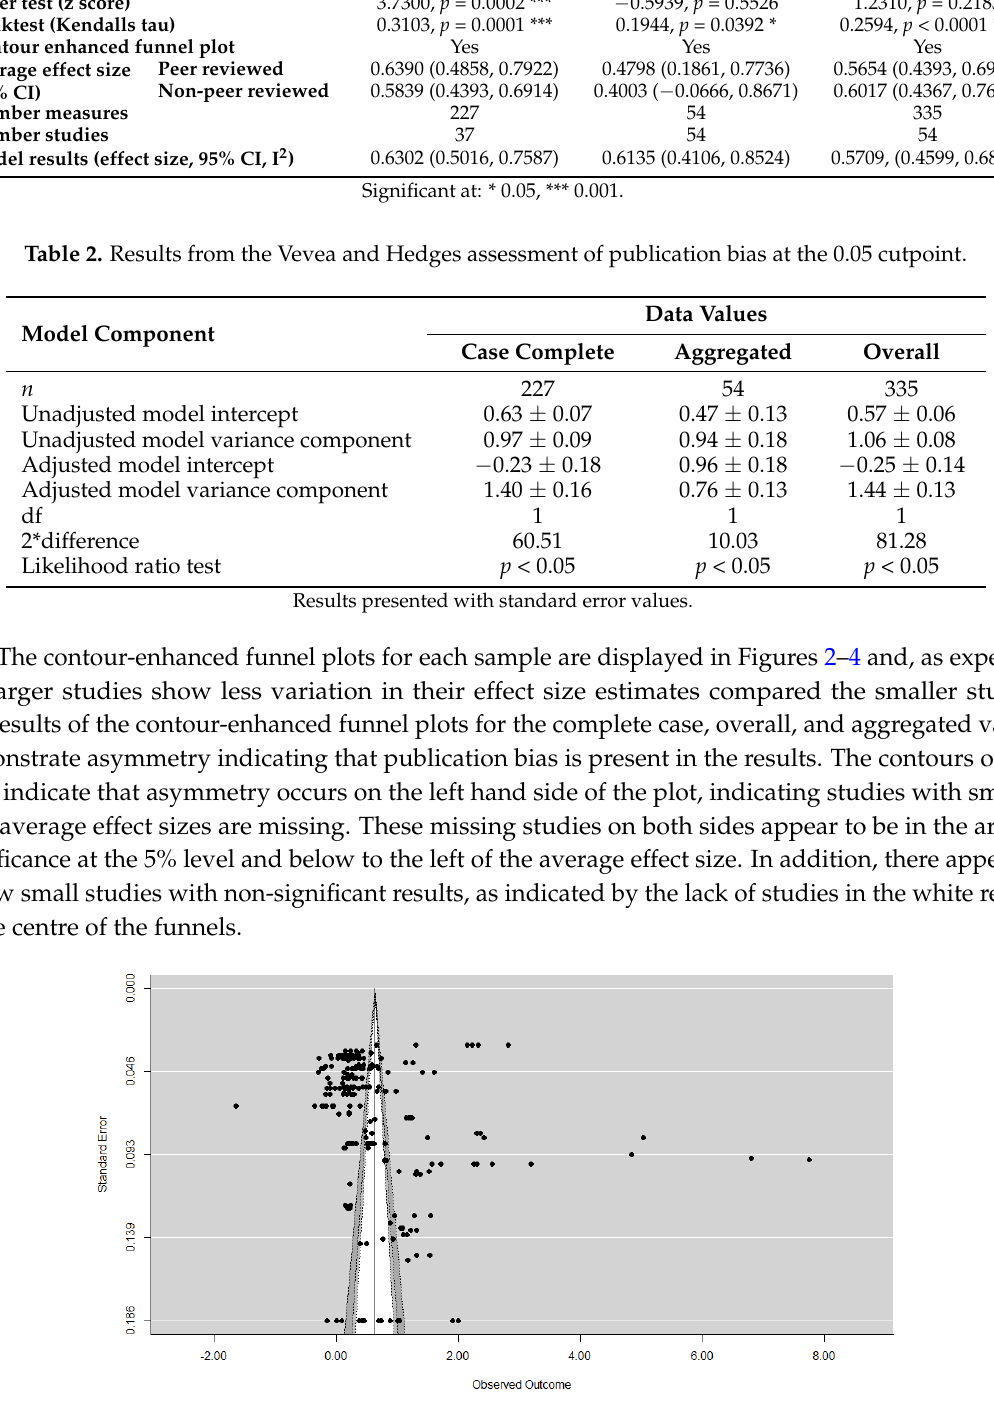
Table 1. Results from five assessments of publication bias.